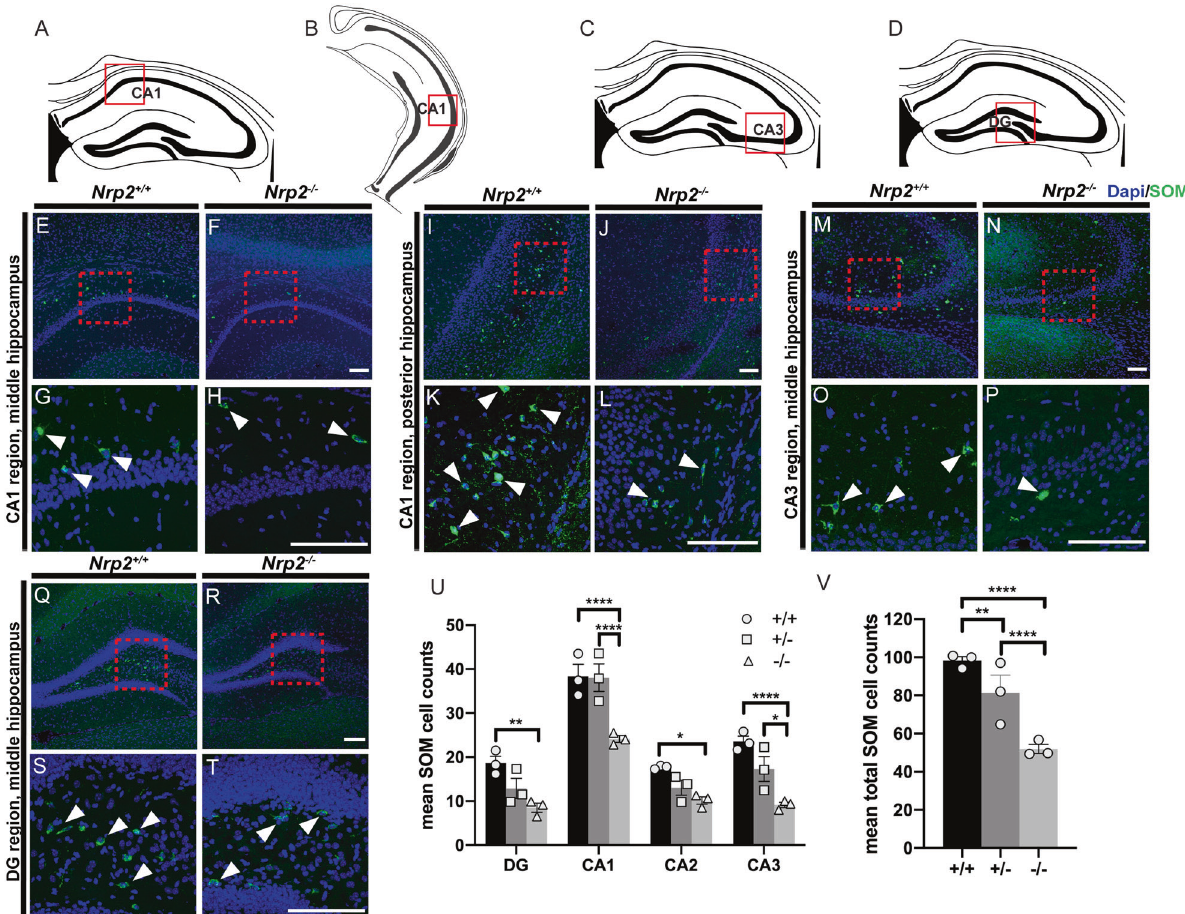
Fig. 3 Somatostatin (SOM) expressing interneurons in all hippocampal subregions are signi fi cantly fewer in number in Nrp2 − / − compared to wild type ( Nrp2 + / + ). A – B Schematics show coronal adult sections of the CA1 region in the middle and posterior hippocampus, respectively. Red box in A and B indicates the CA1 region illustrated by images in E – H and I – L , respectively. C – D Schematics of coronal adult sections in the middle hippocampus, red boxes indicate the CA3 and DG region of images in M – P and Q – T , respectively. E – H Immuno-labeled of littermates Nrp2 + / + ( E, G ) and Nrp2 − / − ( F, H ) sections with anti-SOM (green) and Dapi (blue) in the middle CA1 region. Red boxes in E and F are the locations of the high magni fi cation images shown in G and H , respectively. I – L Immuno-labeled of littermates Nrp2 + / + ( I , K ) and Nrp2 − / − ( J, L ) sections with anti-SOM (green) and Dapi (blue) in the posterior CA1 region. Red boxes in I and J are the locations of the high magni fi cent images shown in K and L, respectively. M – P Immuno-labeled sections from littermates Nrp2 + / + ( M, O ) and Nrp2 − / − ( N, P ) with anti-SOM (green) and Dapi (blue) in the CA3 region. Red boxes in M and N show the location of high magni fi cation images in O and P , respectively. Q – T Littermates Nrp2 + / + ( Q, S ) and Nrp2 − / − ( R, T ) sections are immuno-labeled with anti-SOM (green) and Dapi (blue) in the DG region. Red boxes in Q and R show the location of high magni fi cation images in S and T, respectively. Scale bars: 100 μ m in F, J, N, and R for E-F , I-J, M-N, and Q-R , respectively; 100 μ m in H, L, P, and T for G-H, K-L, O-P, and S-T , respectively. U) Quanti fi cation of the averaged number of SOM + cells by hippocampal region. Signi fi cantly fewer number of SOM + neurons found in CA1, CA2, CA3, and DG regions of Nrp2 − / − compared to Nrp2 + / + mice. Error bars are ± SEM; two-way ANOVA, post hoc Tukey: ** p = 0.0018 + / + vs. − / − in DG; ****p < 0.0001 + / + vs. − / − and + / − vs. − / − in CA1; * p = 0.0193 + / + vs. − / − in CA2; ****p < 0.0001 + / + vs. − / − , * p = 0.0113 + / − vs. − / − in CA3. V) Quanti fi cation of total mean SOM + cells. Signi fi cantly fewer SOM + expressing neurons overall found in the hippocampus of Nrp2 + / − and Nrp2 − / − as compared to Nrp2 + / + mice. Error bars are ± SEM; two-way ANOVA, post hoc Tukey: **** p < 0.0001 + / + vs. − / − and + / − vs. − / − ; ** p = 0.0085 + / + vs. + / − . For U and V, n = 3